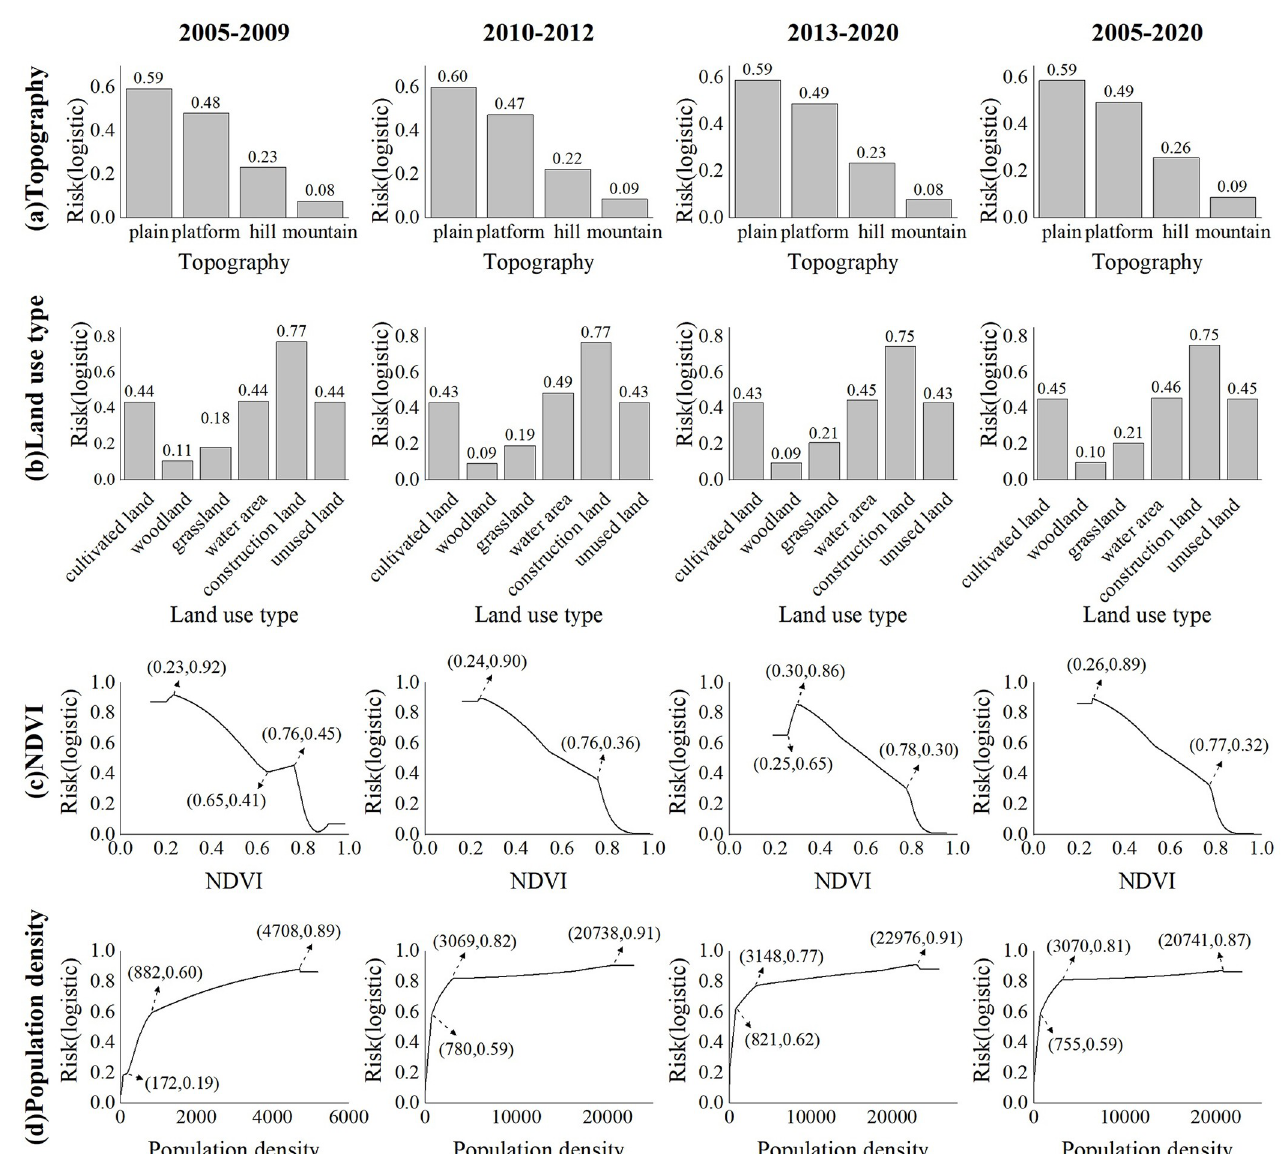
Fig 6. The response curves of the major environmental factors to the risk of HFRS epidemic. a and b were the risk values of different topography and land use on the spread of HFRS epidemic, respectively. c and d were the response curve of NDVI and population density to the spread of HFRS epidemic,